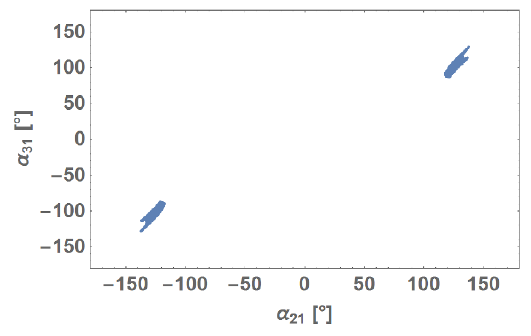
Figure 4 . The prediction of m ee versus m 1 for NH in model I(a). The red vertical line denotes the upper-bound of m 1